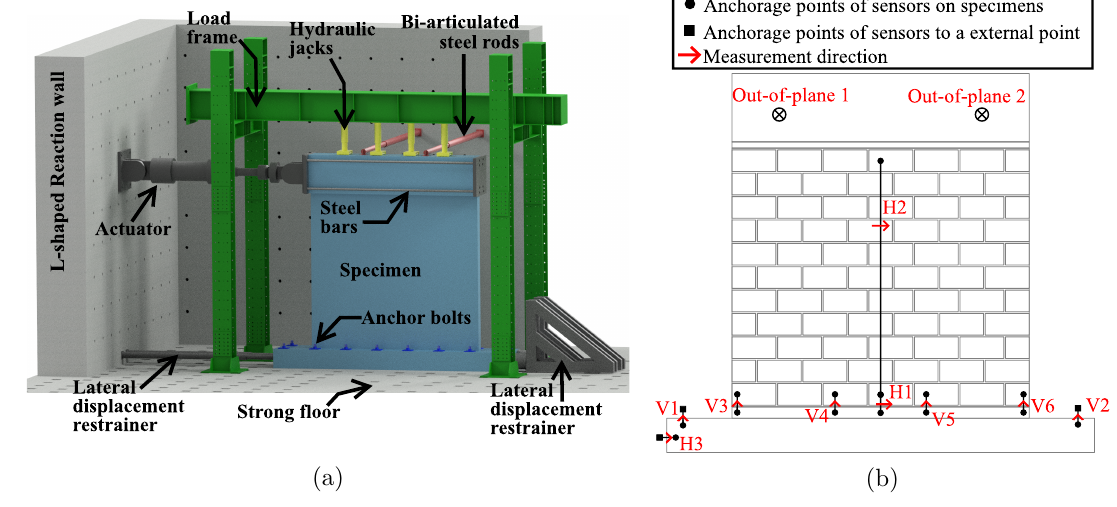
Figure 3. Testing setup: ( a ) general view; and ( b )